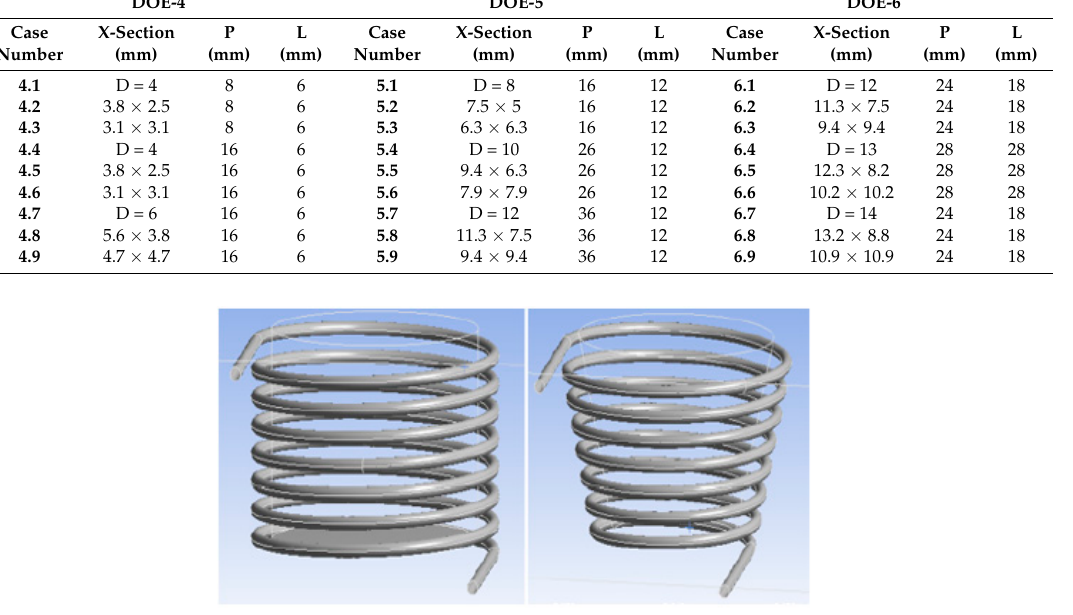
Table 8. Channel dimensions for DOE 4 (plastic part thickness: one mm), DOE-5 (plastic part thickness: 3.5 mm) and DOE-6 (plastic part thickness: six mm).